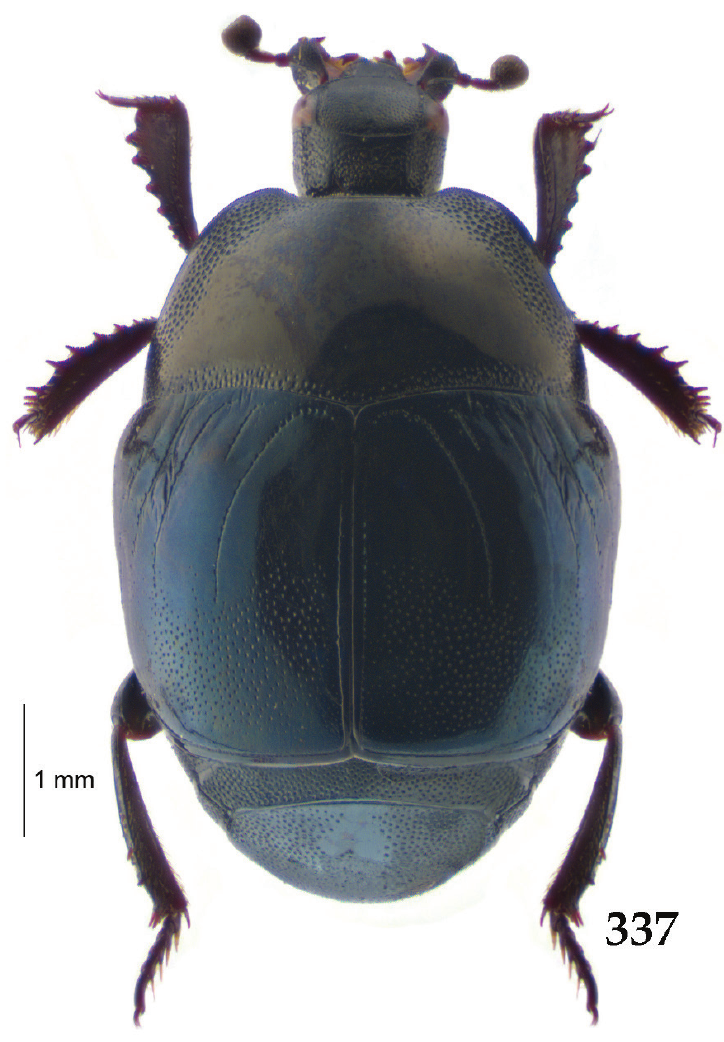
Figure 337. Saprinus ( Saprinus ) australis (Boisduval, 1835) habitus, dorsal view. Additional material examined. AUSTRALIA. Queensland: 1 spec., Queens- land, without further data (ZMHUB); 3 specs., Ewan Road, 8 miles W Paluma, 15.i.1970, J.G. Brooks (fish lure) (ANIC); 3 specs., Mount Mee, 7 km SW, 27°05'S, 152°42'E, 12.x.1991, Tom Gush (under dead snake on road) (ANIC); 7 specs., Mt. Tambourine, xii.1919, H. Pottinger (QM); 2 specs., National Park, xii.1919, H. Hacker (QM); 1 spec., Brisbane, ii.1920, H. Pottinger (QM); 1 spec., Caloundra, 28.ix.1913, H. Hacker (QM); 1 spec., Kroombit Tops (Lower Dry Creek), 45 km SSW Calliope, 9.–19.xii.1983, G. Monteith & G. Thompson (open forest) (QM); 1 spec., McAfee’s Lookout, 300 m, 27°26'S, 152°53'E, 18.x.1999, G. Monteith (open